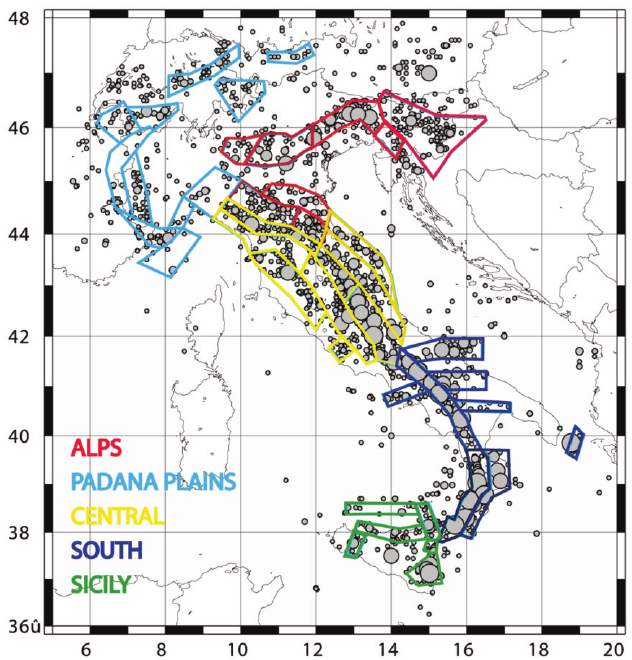
Figure 2. The completeness of the CPTI04 catalog for the five zones where the completeness magnitude threshold changed with time [MSP Working Group 2004].